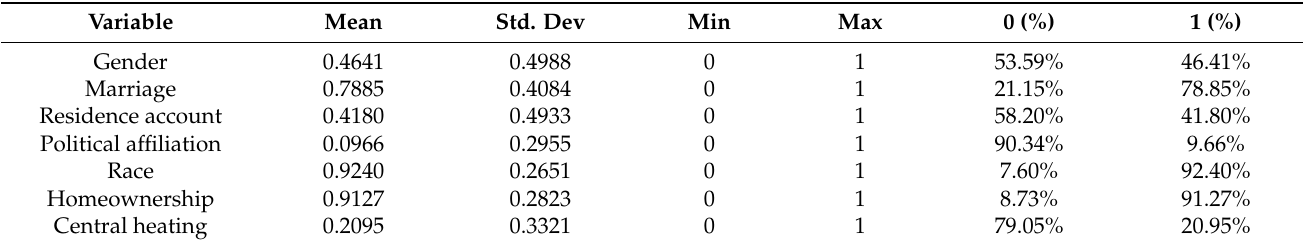
Table 2. Descriptive statistics of binary variables.